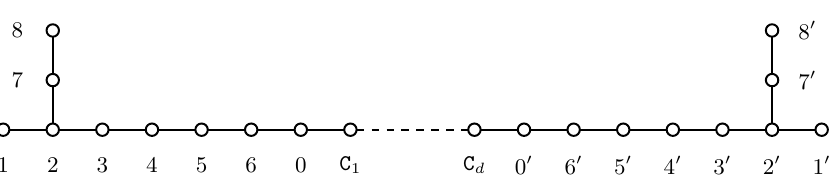
Figure 18. Extended diagram for generic values of d , yielding for example the maximal enhance- ments SO(32 + 2 d ) and SU(17 + d ).